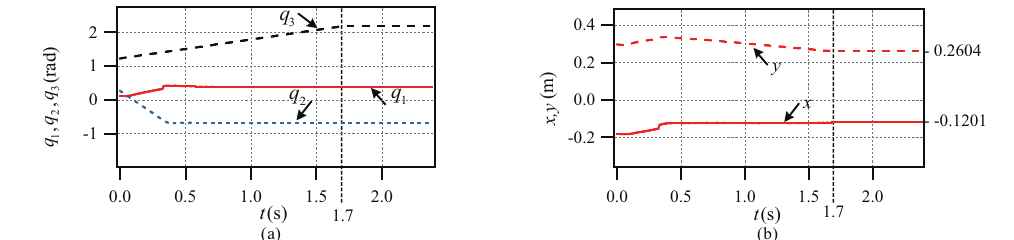
Figure 6. Experimental results of Case B: ( a ) angles of linkages, ( b ) coordinates of end-point.